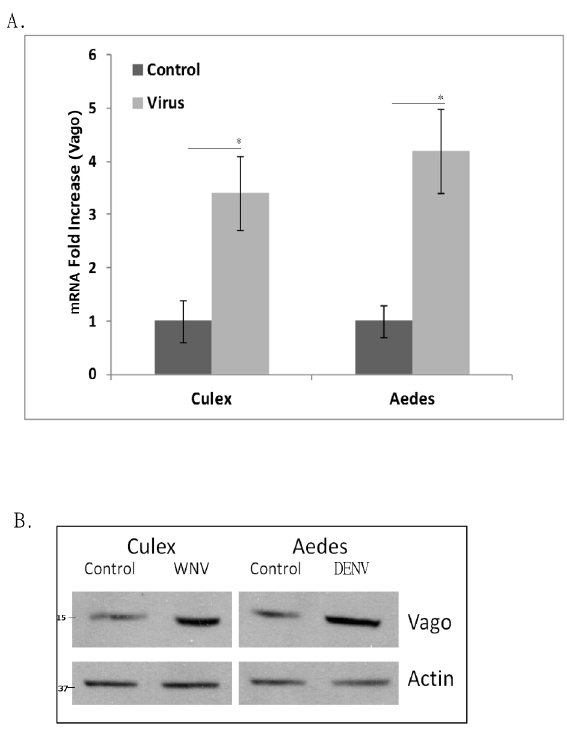
Figure 1. Vago is up-regulated by flavivirus infection in mosquito cells. ( A ) Hsu ( Culex quinquefasciatus ) and RML12 ( Aedes albopictus ) cells were infected with WNV and DENV, respectively, and total RNA was collected at 48 hpi. Real-time RT-qPCR was performed using Vago-specific primers. RpL32 (ribosomal protein L32) primers were used as an internal control. Error bars represents standard error from three separate experiments with assays performed in triplicate (Student’s t-test *p , 0.05, comparing mRNA level between control and virus-infected cells). ( B ) Cells treated as in (A) were lysed to harvest total protein samples. Western blotting was performed using anti-Vago and anti-beta actin antibodies.